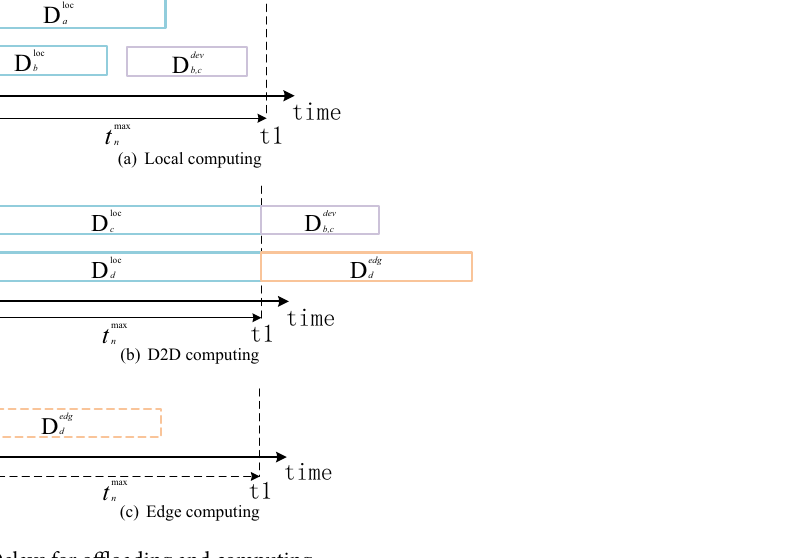
Figure 2. Delays for offloading and